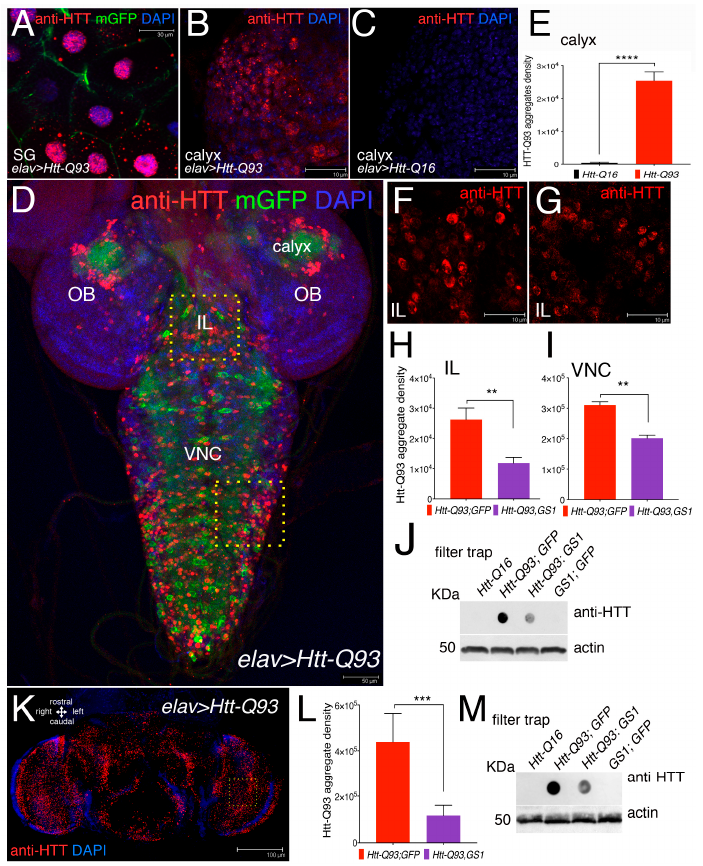
Figure 3. Expression of GS1 in neurons reduces the presence of Htt-Q93 aggregates. ( A ) Confocal microscopy images of cells from the salivary gland (SG), where the elav-Gal4 insertion is also transcriptionally active, showing the presence of Htt-Q93 protein aggregates (red), that are visible in the cytoplasm and in the nuclei of cells expressing UAS-Htt-Q93 and UAS-GFP , immunostained with anti-hHtt antibodies. Nuclei are stained with 4 ′ ,6-diamidino-2-phenylindole (DAPI); bar 30 µm. ( B ) Htt-Q93 aggregates visualized in the region from the calyx, ( C ) that are not detected in the calyx from control Htt-Q16 animals; bar 10 µ m; ( E ) relative quantification of the fluorescence in ( B , C ). ( D ) Confocal image of the whole brain from third instar larvae expressing Htt-Q93 and GFP ( elav-Gal4 ; Htt-Q93 ; mGFP ); the Htt-Q93 aggregates are visualized by immunofluorescence and nuclei with DAPI, bar 50 µ m. The yellow squares represent the regions where the Htt-Q93 aggregates were quantified: the Ventral Nerve Cord (VNC) and the intralobe region (IL), in addition to the calyx. ( F , G ) Picture representing the Htt-Q93 aggregates visualized in the intralobe (IL) region from Htt-Q93 (F) or Htt-Q93; GS1 ( G ) animals; bar10 µ m; the relative quantification analysis is shown from the IL ( H ) and in the Ventral Nerve Cord (VNC) ( I ). Quantification of the aggregate density was calculated in the relative area and measured as the integrated density of the immunofluorescence signal visualized using anti-human Htt antibody from 10 confocal z -stacks for each animal and elaborated with ImageJ, (see Materials and Methods). ( J ) Filter trap analysis using lysates from the brains of the indicated transgenes; the expression of actin in the same extracts was analyzed by western blot as an internal control for loading. ( K ) Confocal image of elav-Gal4; Htt-Q93 adult female’s head at 10 DAE, immunostained with anti-hHtt antibody showing the presence of Htt-Q93 aggregates (RED, nuclei DAPI), bar 100 µ m. ( L ) Quantification of the Htt-Q93 aggregates in the heads of the animals of the indicated genotypes from confocal z -stacks; analysis was performed in the area indicated by the square. ( M ) Filter trap analysis of Htt-Q93 protein aggregates using lysates from the heads. Actin was used as the internal control. The ** p < 0.01, *** p < 0.001, **** p < 0.0001, values in panels ( E , I , J , M ) were calculated from Student’s t -test from at least three independent experiments, where error bars indicate the standard deviations. OL = optic